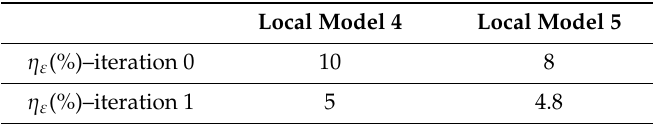
Table 10. η ε values for Local Model 4 and Local Model